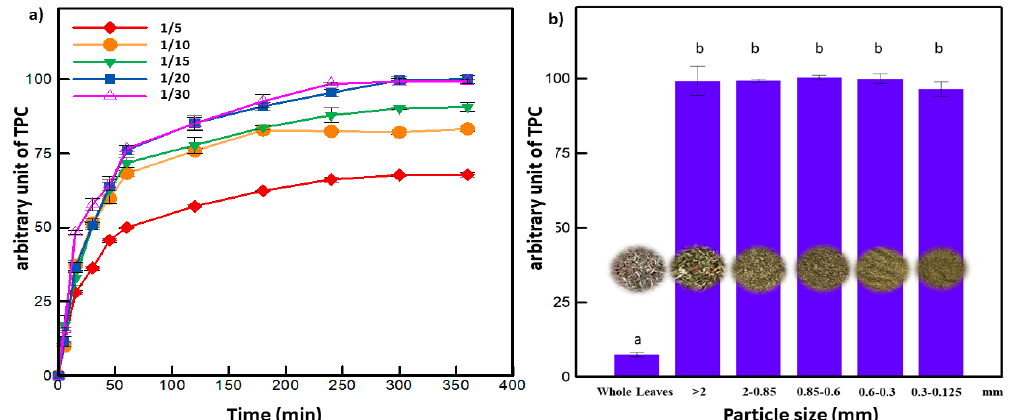
Figure 2. ( a ) Effect of solid to liquid ratio and ( b ) particle size on the extraction yield (letters a and b indicate significant statistical difference between means). Every arbitrary unit value is the ratio of the Total Phenolic Compounds (TPC) (at the corresponding experimental conditions) to the highest obtained TPC.